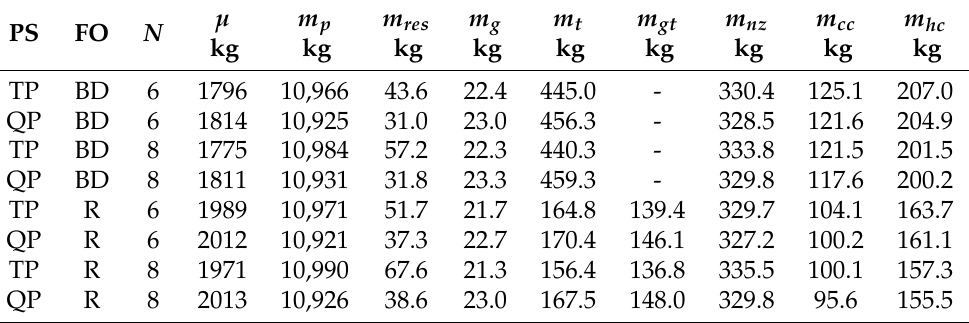
Table 4. Mass budget for different port shapes (PS): triangular ports (TP) and quadrangular ports (QP). The second column reports the feed system option (FO): blow down (BD) and regulated (R). The average mixture ratio and specific impulse are reported as α avg and ( I SP ) avg , respectively. m res is the residual propellant mass, m g is the pressurizing gas mass, m t is the tank mass, m gt is the pressurizing gas tank mass, m nz is the nozzle mass, m cc is the combustion chamber mass and m hc is the engine casing